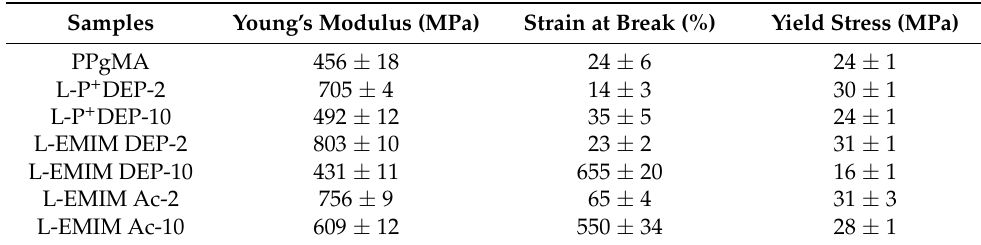
Table 5. Mechanical properties of PPgMA and related LIonomers (from tensile tests performed at room